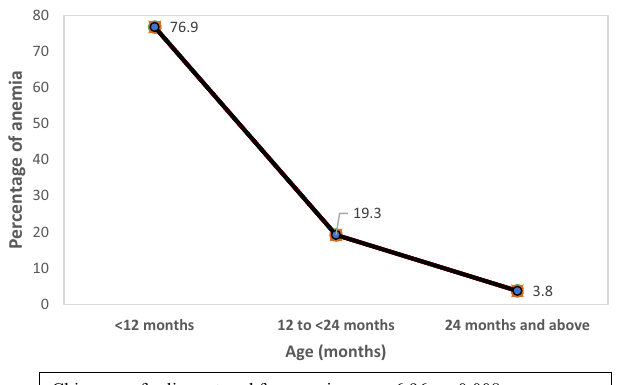
Figure 2. The inverse relation of anemia with increasing age among children under five hospitalized for pneumonia/severe pneumonia using Chi-square for linear trend for